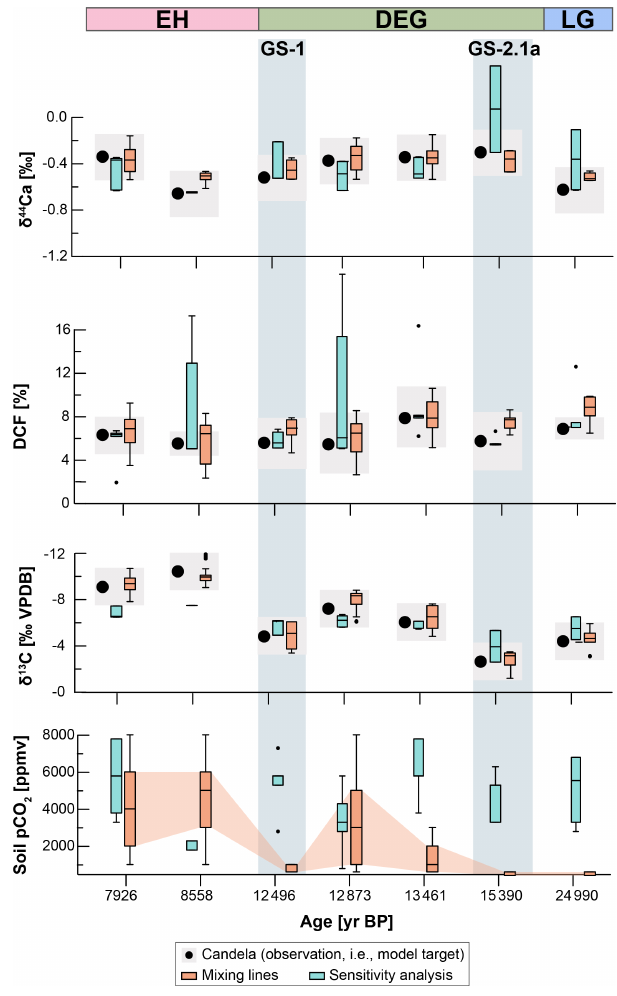
Figure 6. Modelling results compared to measured proxies in stalagmite Candela. Stalagmite measurements ( δ 13 C spel , DCF, δ 44 / 40 Ca; black dots) are compared to best-fitting model solutions (colour-coded by simulation type). Simulation results are shown as box plots, with the median and upper and lower quartiles displayed. Outliers are shown as dots. Grey shading indicates intervals of the measured proxy values used to filter the simulations. The soil gas p CO 2 derived from the different model solutions is shown. The time periods (LG, DEG, EH) at the top of the figure indicate the intervals used for the modelling to define temperature and atmo- spheric p CO 2 .